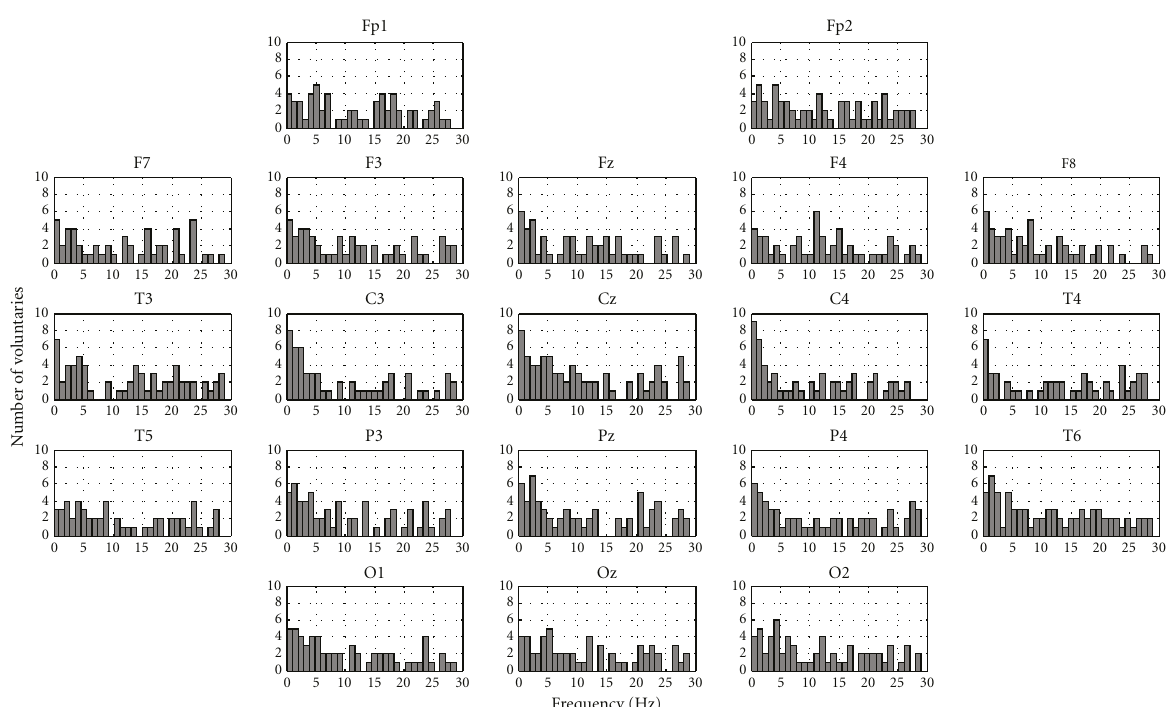
Figure 11: Histogram (bin width 1Hz) topographic distribution displaying the number of subjects with response after MSC application higher than the critical value (significance level 5%) for ERPs during left index finger movement imagination, harmonics from 0 to 30 Hz. Frequencies higher than 30Hz did not show significant